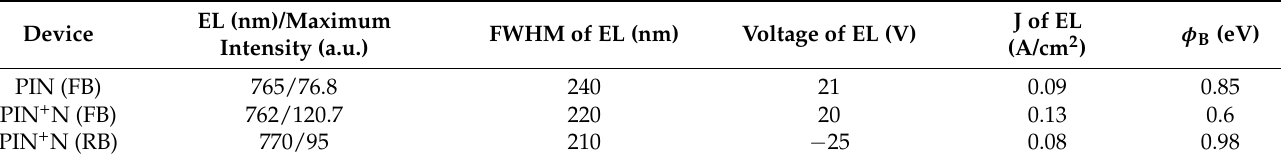
Table 3. Electroluminescence properties of PIN and PIN + N devices.